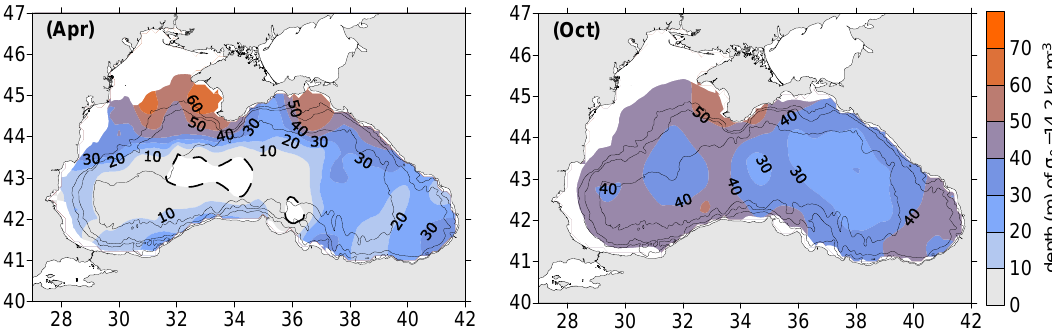
Fig. 3. Depth of climatically averaged isopycnic surface σ θ = 14 . 2kgm − 3 in April and October (shaded and numbers). The isobaths are shown at 200, 1000 and 2000m levels (thin solid lines). The April plot also shows the contour of this isopycnal along the sea surface (dashed line).